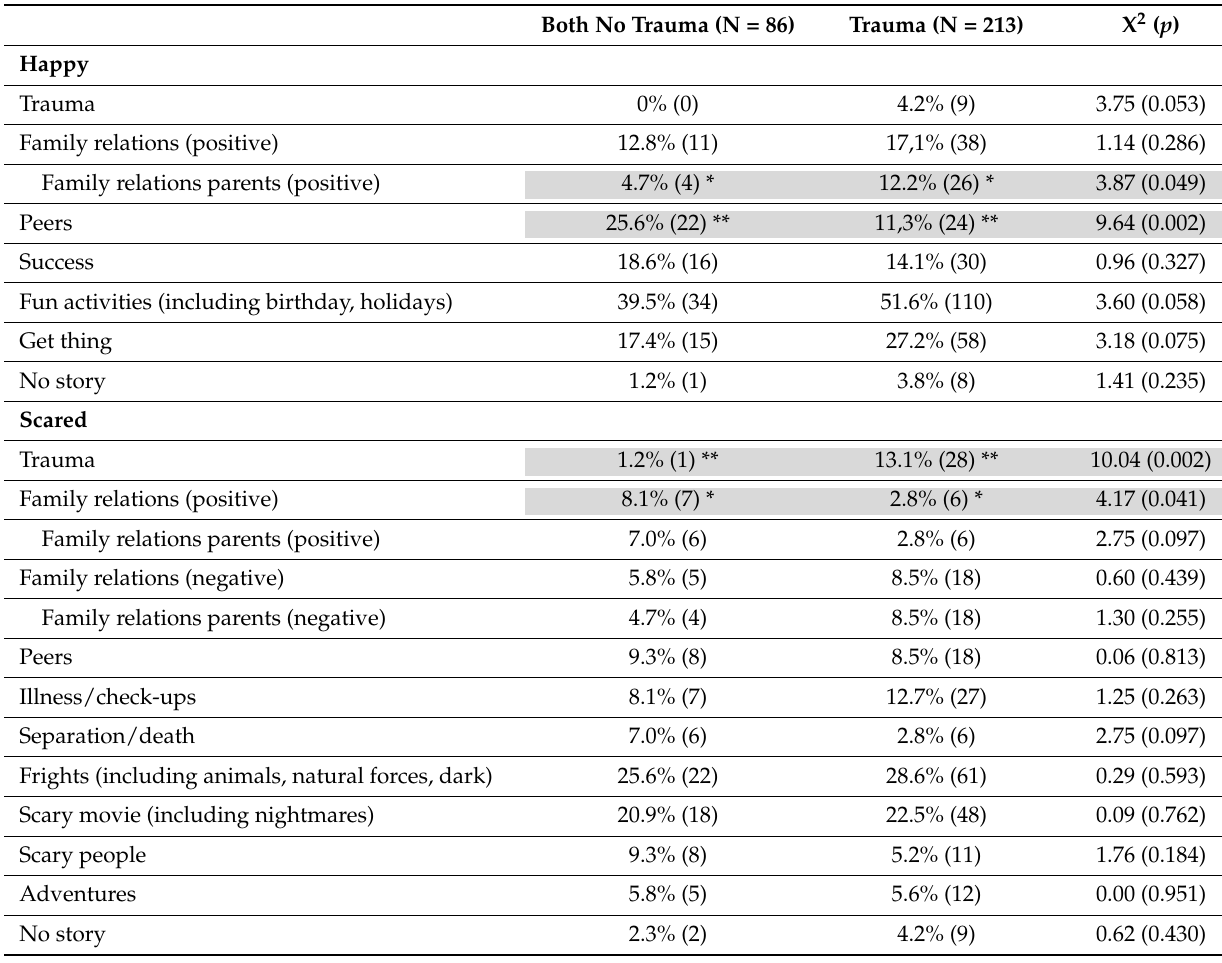
Table 2. Frequency of topics between dyads with and without interpersonal trauma